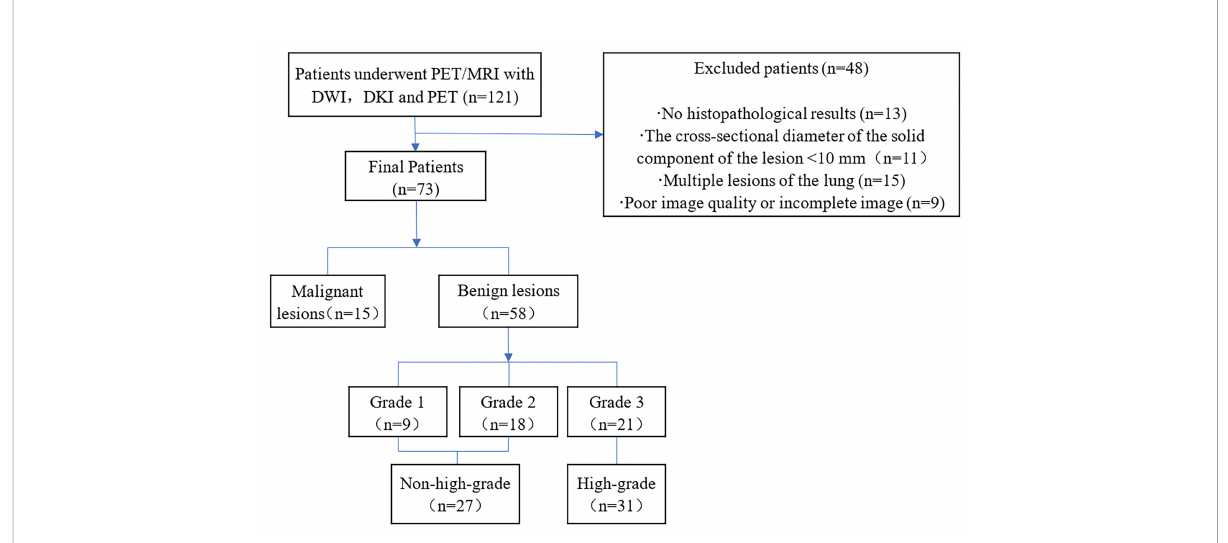
FIGURE 1 Flow diagram of the patient selection